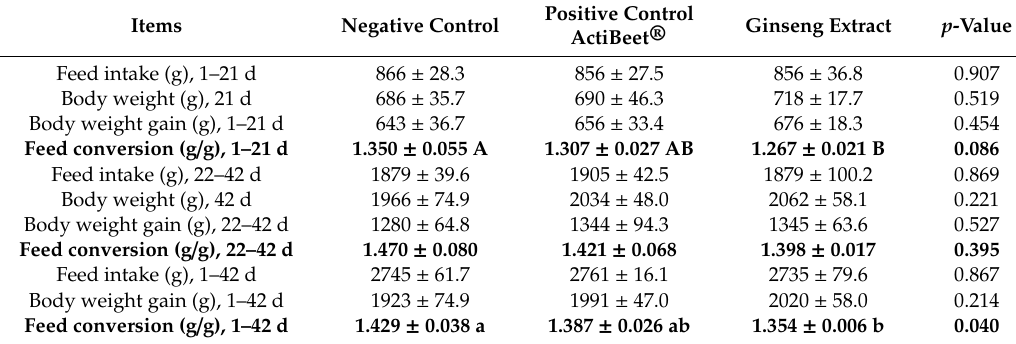
Table 1. Feed intake and growth performance of growing broilers under normal temperature conditions